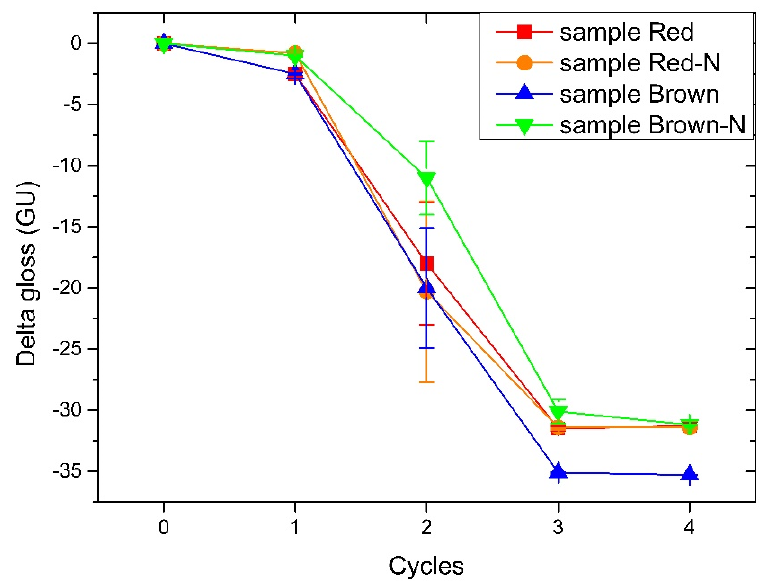
Figure 6. Gloss evolution as a function of the degradation cycles.